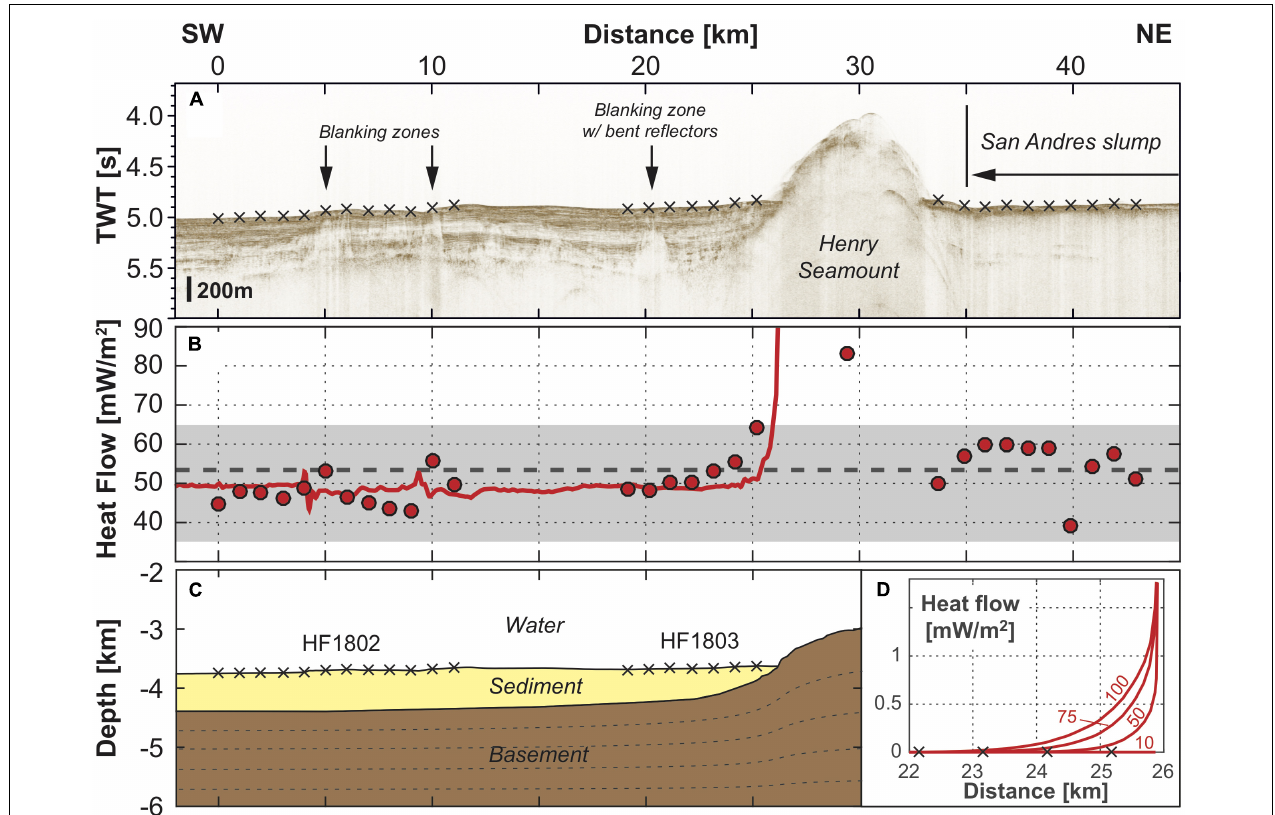
FIGURE 4 | (A) Southwest-northeast traverse across Henry Seamount as indicated in Figure 1A , showing the reflection seismic profile (vertical exaggeration 6 × ) and locations for heat flow measurements (crosses). The seismic data reveal several blanking zones, which may reflect the presence of gas hydrates (Lee and Dillon, 2001) or hydrothermal alteration of sediments by fluid circulation (Caratori Tontini et al., 2019). Boundary of the San Andres slump deposits after Gee et al. (2001). (B) Heat flows (red circles) determined along the seismic profile; the range for all other heat flow values near Henry Seamount ( Figure 1A ) is marked by gray shading. Except for a single value obtained near the summit, heat flow values cluster around the predicted lithospheric heat flow for 155 Ma old crust (dashed gray line; Hasterok, 2013). The solid red line shows the predicted conductive surface heat flow for the basal heating model shown in Panel C . (C) Geometry and parameters of the two-dimensional model used to simulate the surface heat flow southwest of Henry Seamount (see Supplementary Material for details of the calculations). Dashed lines symbolize isotherms; HF1802 and HF1803 are heat flow profiles. (D) Calculated seafloor heat flow at the southwestern base of the seamount for conductive cooling of a hypothetical cylindrical intrusion (see Supplementary Material for model details). Distance refers to the profile in panel A , numbers at calculated curves indicate intrusion age in ka, stars mark the heat probe locations of profile